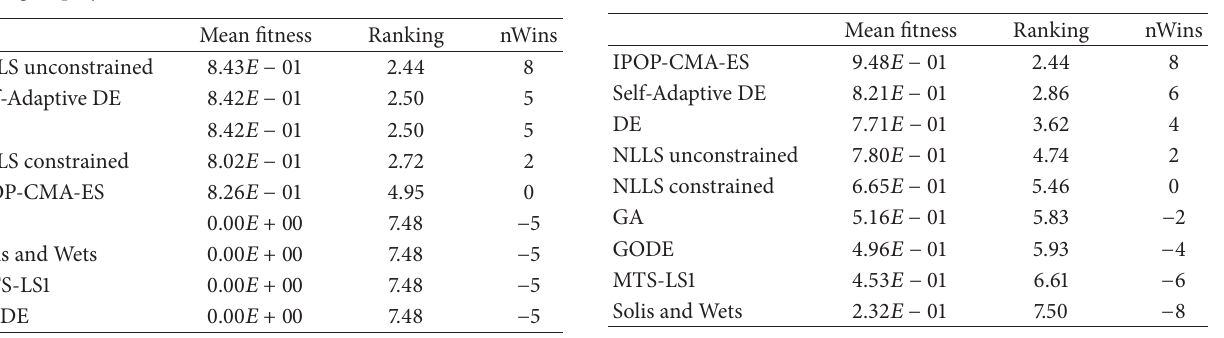
Table 17: Mean fitness, average ranking, and number of wins (nWins) in pair-wise comparisons with the other algorithms on the 9th degree polynomial.